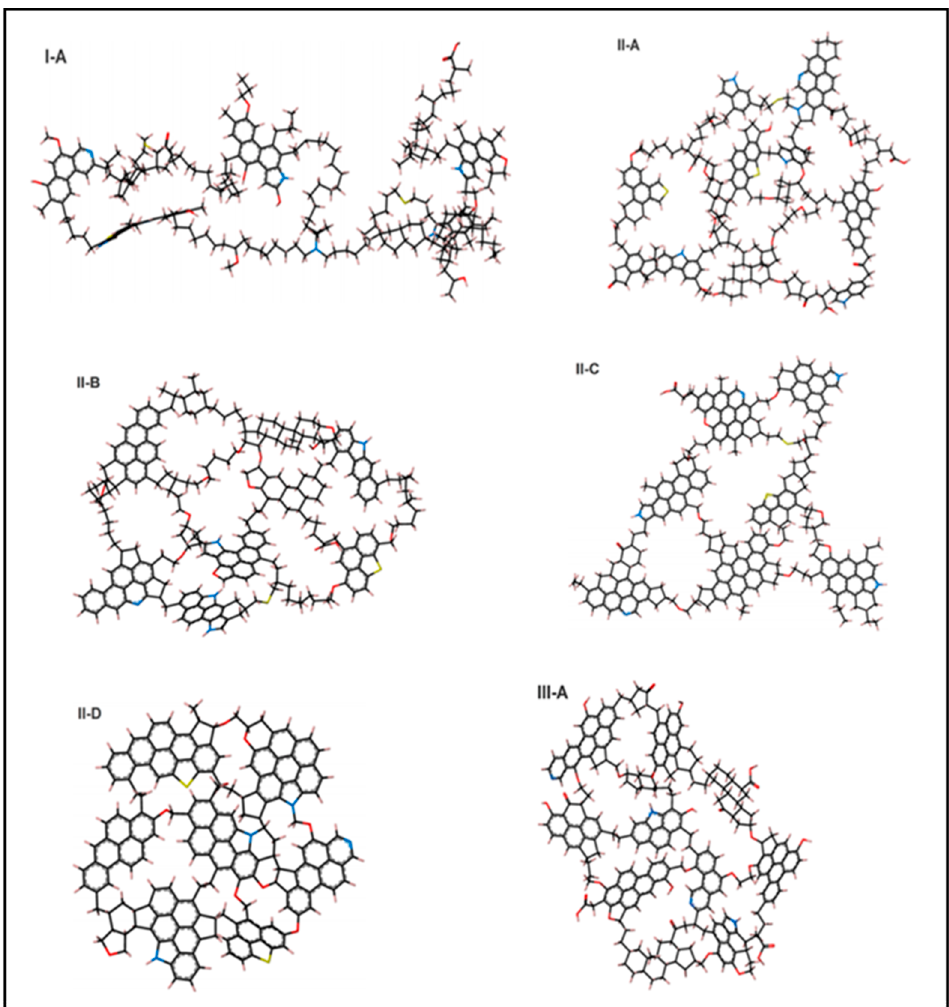
Figure 1. Six prototype kerogen macromolecules [39].